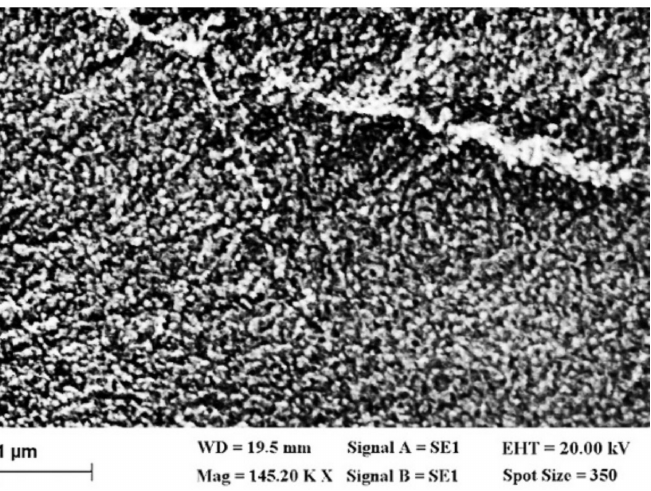
Figure 2. Typical SEM image of AZO layer deposited on PET substrate.